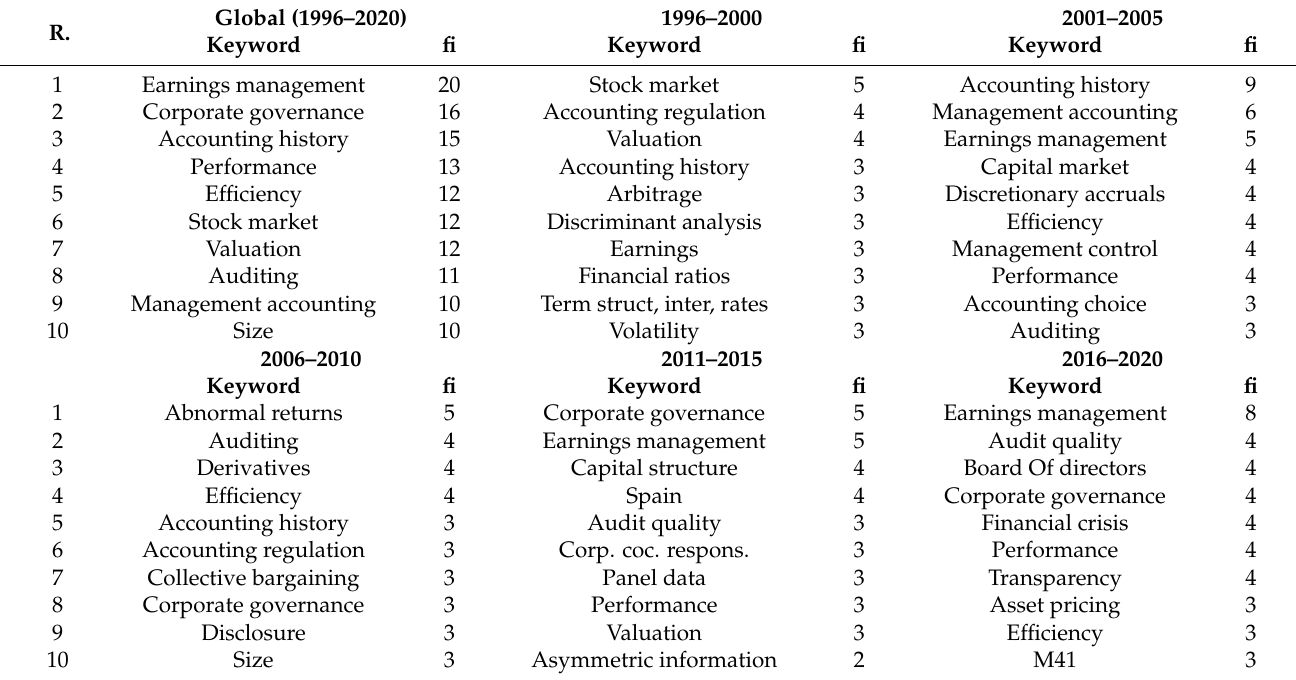
Table 12. Keywords used most frequently by